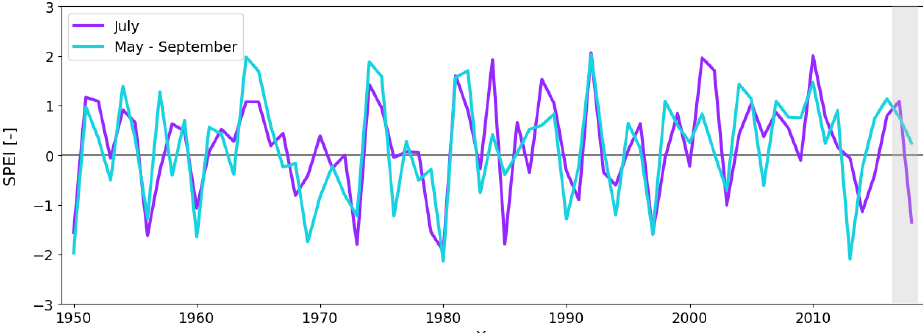
Figure 7. The 1-month (July) and 5-month (May–September) Standardised Precipitation Evapotranspiration Index (SPEI) at Kaamanen in 1950–2018. Positive SPEI values denote moist conditions and negative values drought conditions. The years 2017 and 2018 are marked with